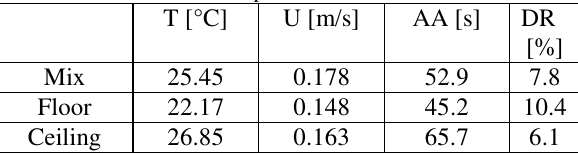
Table 2 . Time averaged temperature, velocity magnitude, AA and DR in point at driver’s nose.